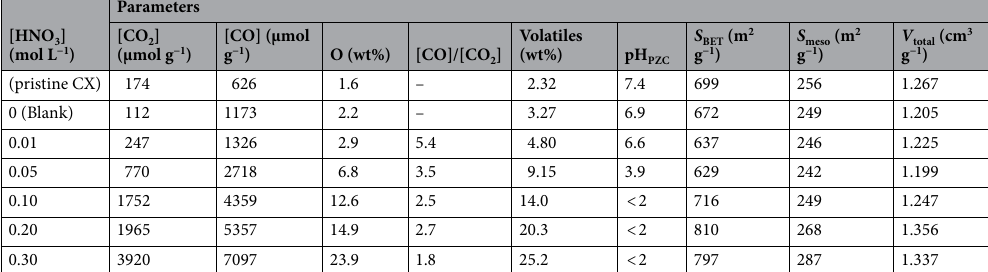
Table 1. Properties of the pristine CX material and CXs subjected to hydrothermal treatment with different HNO 3 concentrations: amounts of CO 2 and CO released by TPD, [CO/CO 2 ] ratio, percentage of oxygen obtained from the analysis of the TPD spectra (assuming that all the surface oxygen is released as CO and/or CO 2 ), amount of volatiles (determined by TGA), pH at the point of zero charge (pH PZC ), specific surface area ( S BET ), non-microporous specific surface area ( S meso ) and total pore volume ( V total ).